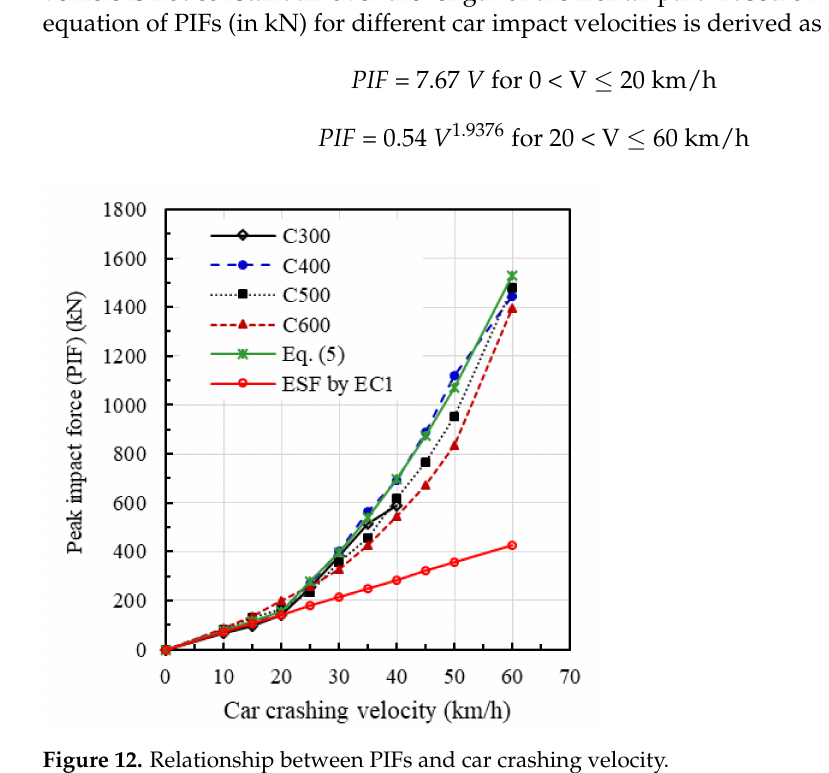
Figure 12. Relationship between PIFs and car crashing